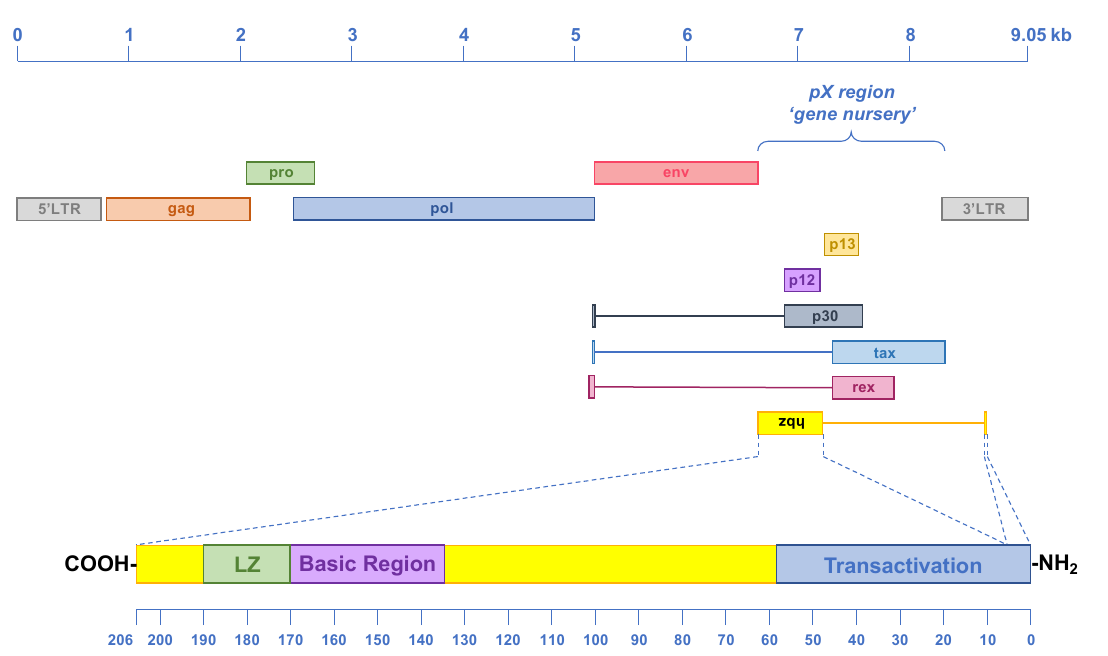
Figure 2. Genomic organization of the HTLV-1 provirus and main structural features of HBZ. The hbz gene is located within the pX region of the proviral genome gene, and it overlaps the p12 and p30 ORFs. HBZ is a basic leucine zipper (bZIP) transcription factor of 206 aa, and it contains three main domains: the transactivation domain, the basic region, and the leucine zipper (LZ). HBZ is involved in the establishment of HTLV-1 latency by preventing the recruitment of the HTLV-1 transactivator Tax to the proviral 5 ′ LTR region.